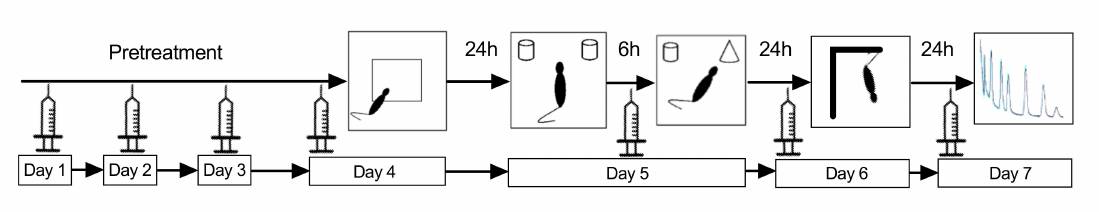
Figure 8. Experimental